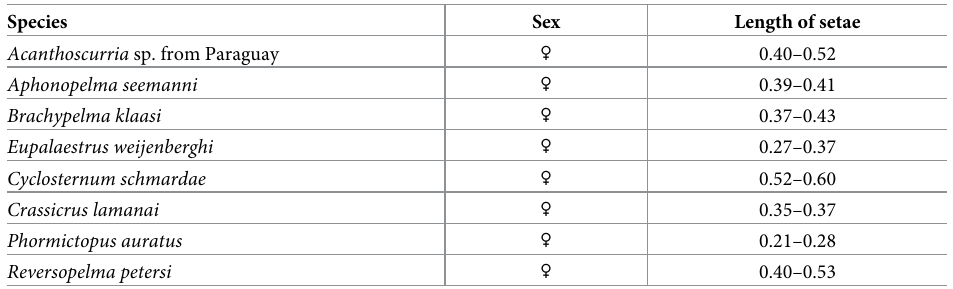
Table 2. Length ranges of basic type I